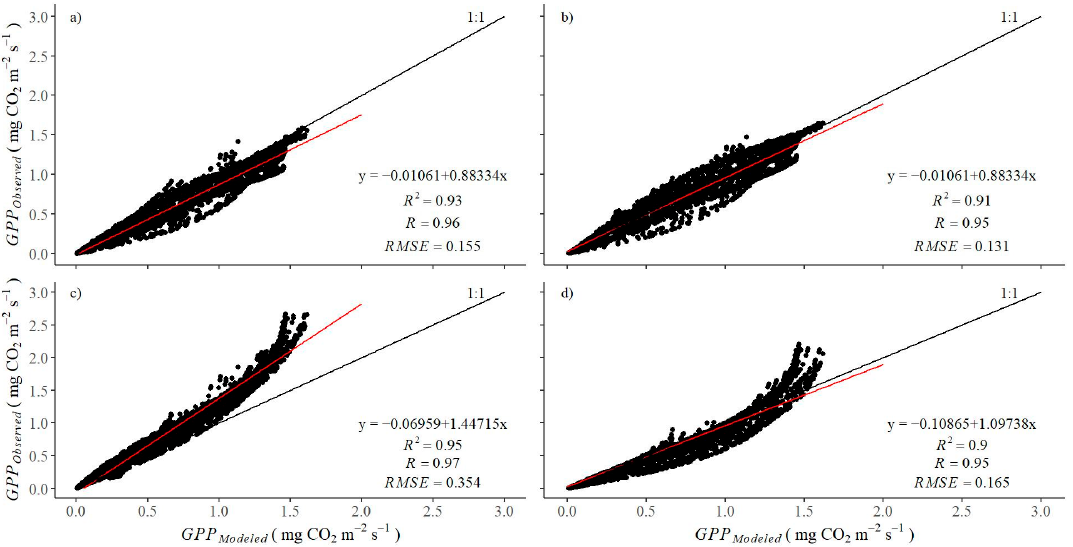
Figure 8. One-to-one comparison of the measured gross primary production (GPP) and the GPP simulated by ( a ) multilayer Mitscherlich (Webb), ( b ) multilayer Michaelis–Menten (Smith), ( c ) big-leaf Michaelis–Menten (Baly), and ( d ) big-leaf Michaelis–Menten (Smith) approaches. Equations, root mean squared error (RMSE), determination and correlation coefficients (R 2 ) are inserted inside graphs.